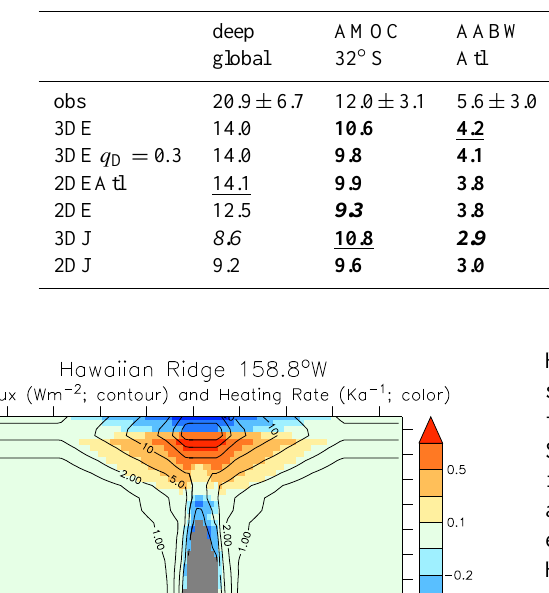
Table 3. Ocean circulation indices in Sverdrups. “Mid global” denotes the strength of the mid-depth global meridional overturning cell. In the model it was calculated as the global maximum stream function below 400m and north of the Equator. “Deep global” is the deep overturning cell calculated as the (negative) minimum of the global stream function below 1.5km depth. “AMOC 32 ◦ S” is the maximum stream function below 300m in the Atlantic at 32 ◦ S, “AABW Atl” is the (negative) minimum stream function in the Atlantic below 1km at 35 ◦ S. CDW represents inflow of Circumpolar Deep Water in the Indian and Pacific oceans at 32 ◦ S. The first row shows independent estimates from an inverse model solution that uses observations (first 5 columns; Lumpkin and Speer, 2007; mid and deep global from their Fig. 2; others from Fig. 4) and, in the column labeled AMOC 26 ◦ N observational estimates from the RAPID array. RAPID transport time series data were downloaded data from http://www.rapid.ac.uk/rapidmoc on 26 July 2013. Eight annual means were calculated from April 2004 to March 2012, as in McCarthy et al. (2012) but with one additional year. The value of 17.5 Sv reported in the table is the average over all eight years, the error estimate represents the standard deviation of the annual values. Bold numbers are within the observational error estimates and underlined and italic numbers are the best and worst matches for that particular index, respectively. The last column (RMSE) presents the root mean of squared errors of the other columns in Sverdrups.